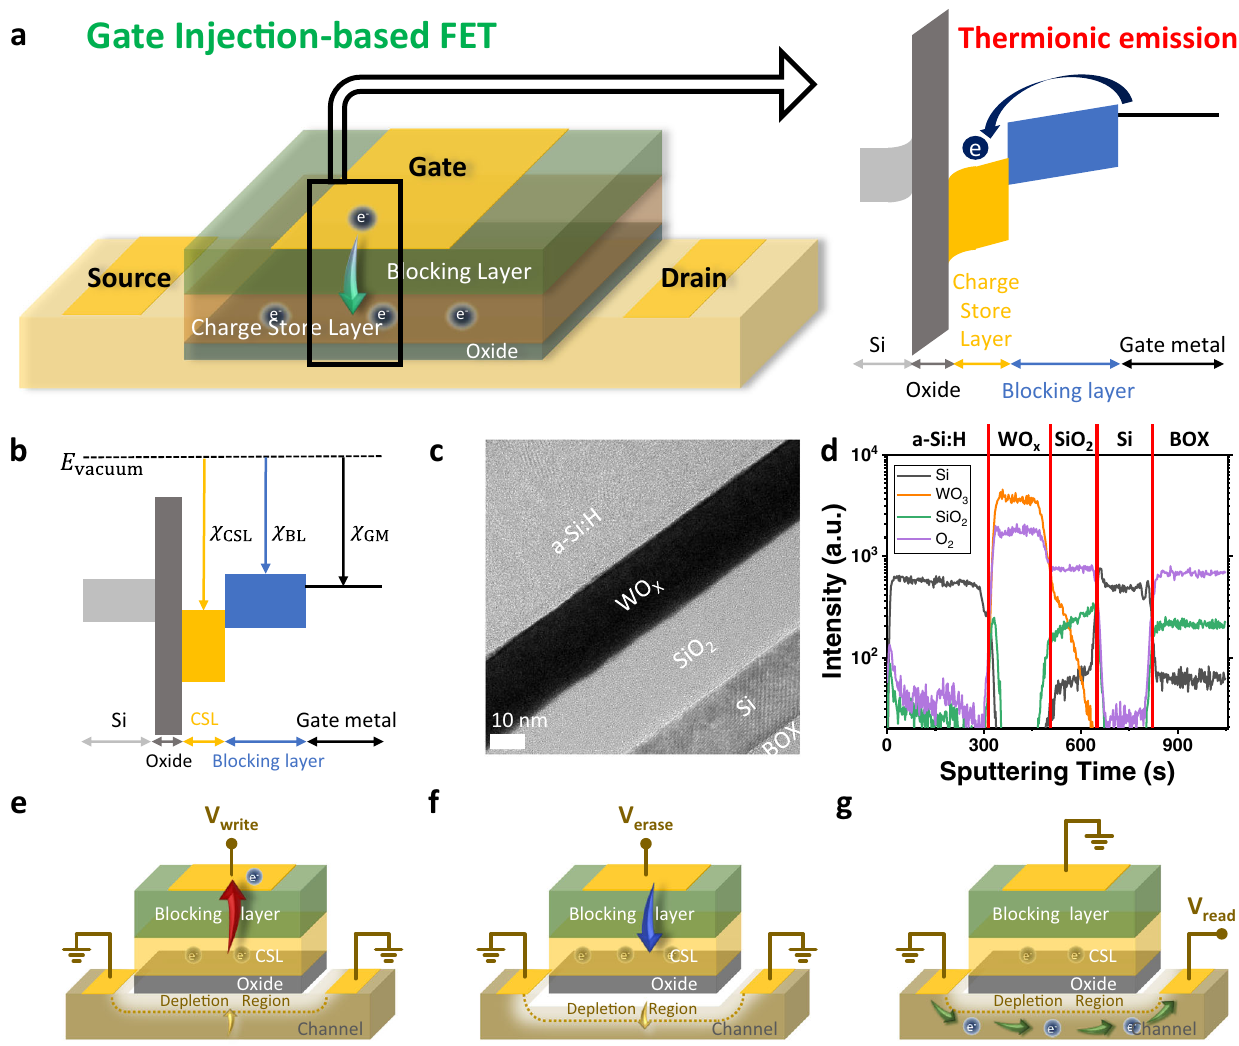
Fig. 1 | Structure and operation principle of GIFET. a Schematic and band dia- gram of GIFET. The charge is injected from or extracted to gate metal by ther- mionic emission. b Flatband diagram of GIFET. The electron af fi nity of the charge storelayer(CSL)ishigherthantheblockinglayer. c TEMimageofthecrosssection